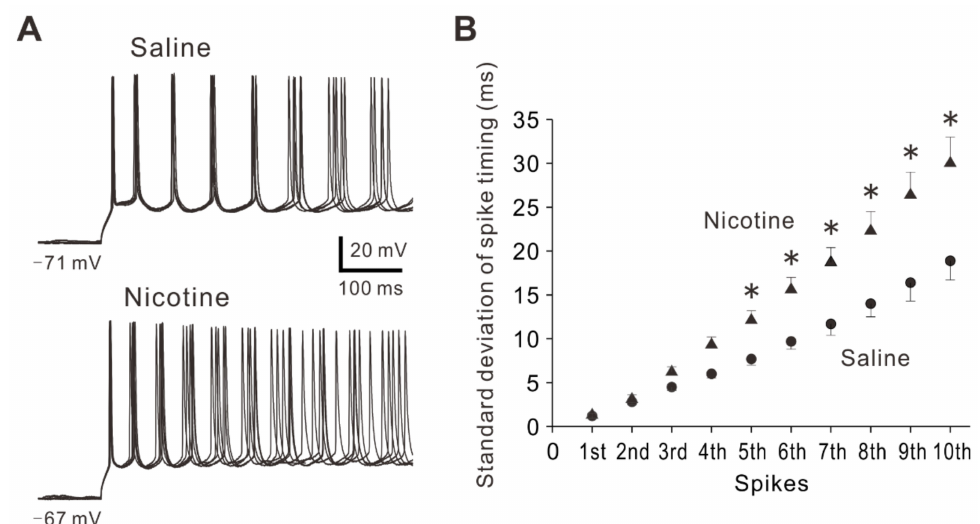
Figure 6. Effects of adolescent nicotine exposure on SDST. ( A ) Sample traces of voltage responses evoked by depolarizing current pulses at the intensity of 180 pA obtained from PNs of a saline-treated mouse (top) and a nicotine-treated mouse (bottom). ( B ) Relationship between spike number and SDST obtained from PNs of saline-treated mice (n = 16 neurons/6 mice) and nicotine-treated mice (n = 15 neurons/7 mice). Two-way repeated measures ANOVA post-hoc LSD, *: p <